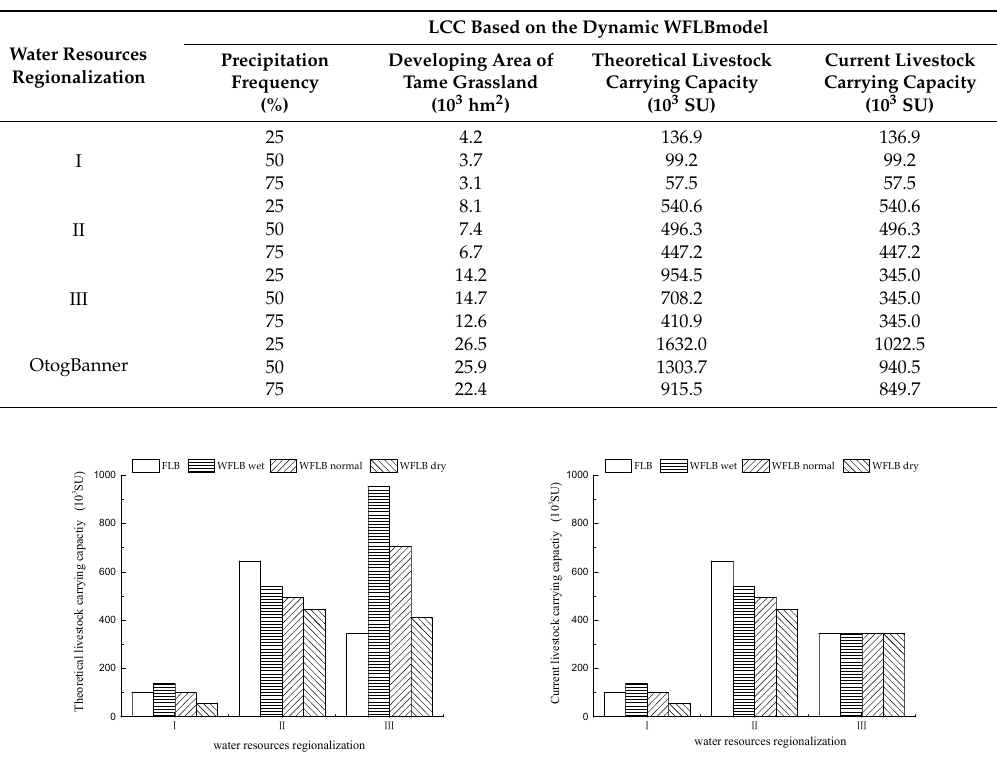
Figure 3. The comparison of LCC with two balance models.